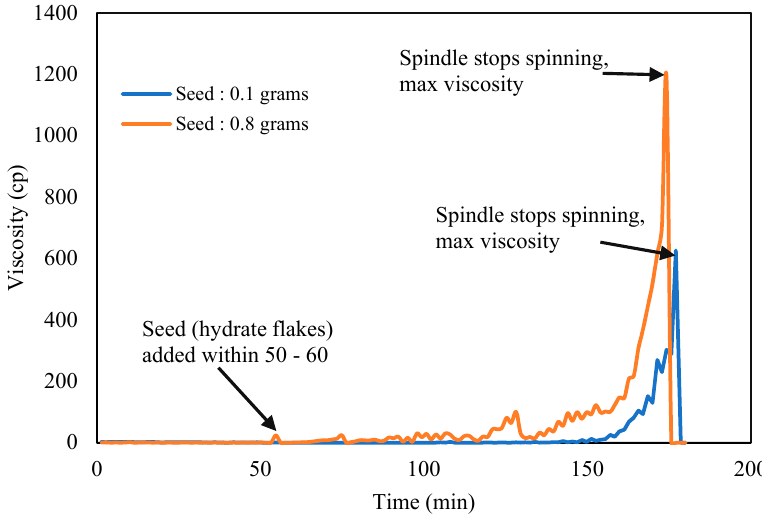
Figure 5. CP–water mixture viscosity with hydrate seeds/flakes addition.